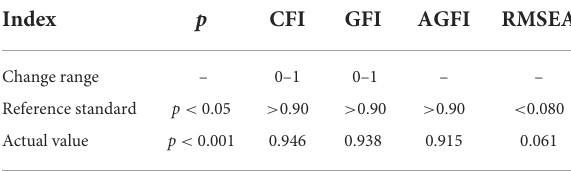
values indicated that the hypotheses model fits the empirical data very well in this study.